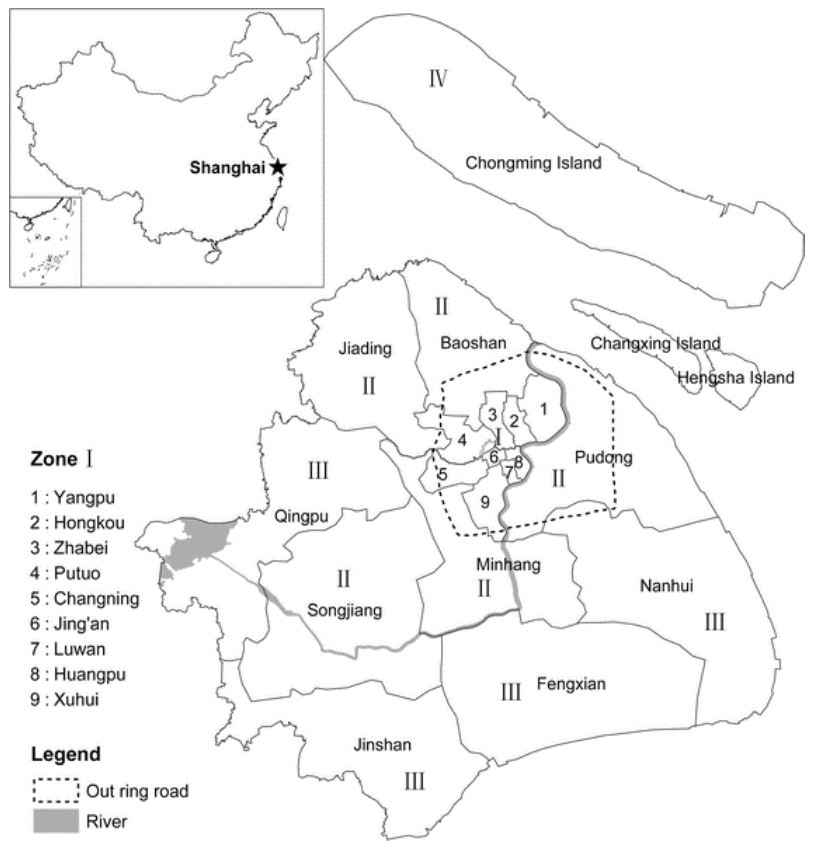
Figure 1. Location of Shanghai and the districts in China [61]. Note that Nanhui district was officially assigned to Pudong New Area on 9 August 2009. Huangpu district and Luwan district were abolished to establish the new Huangpu district in 2011. The State Council approved the withdrawal of Jing’an district and Zhabei district to build a new Jing’an district in November 2015. Table 1. Urbanization indicators of Shanghai between 2005 and 2010